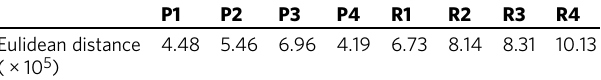
Table 2 EDs between Fe 2 O 3 -treated and control